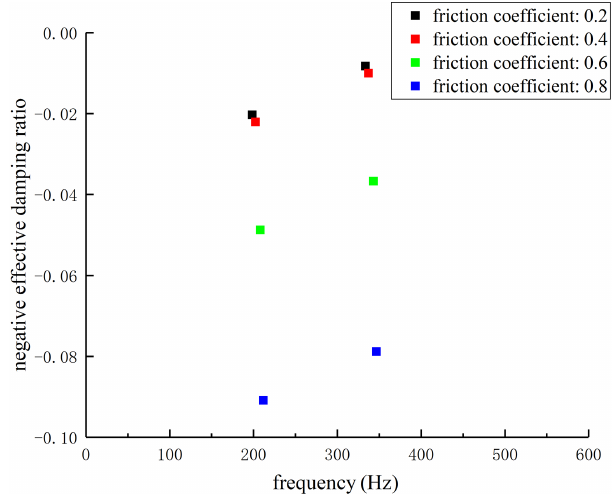
Figure 7. Influence of friction coefficients on the vibration stability of the wheel–rail